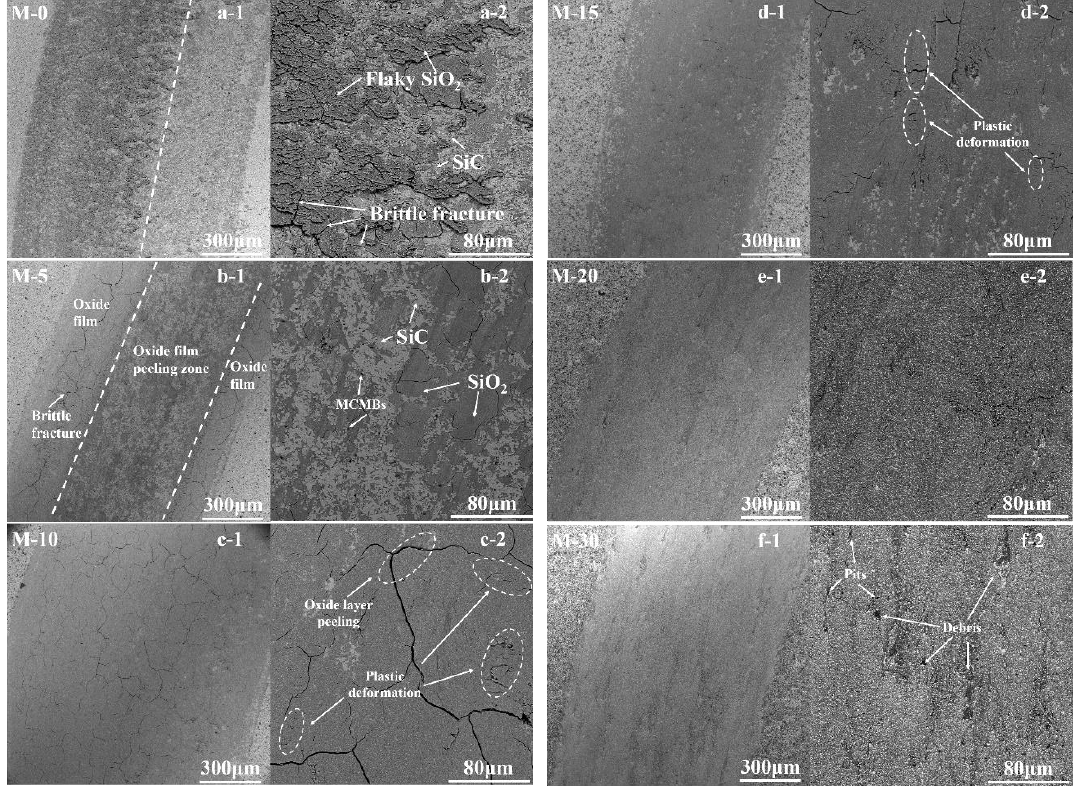
Figure 10. Worn surface morphologies of the samples; ( a-1 , a-2 ) M-0, ( b-1, b-2 ) M-5, ( c-1, c-2 ) M-10, ( d-1 , d-2 ) M-15, ( e-1 , e-2 ) M-20, and ( f-1 , f-2 )